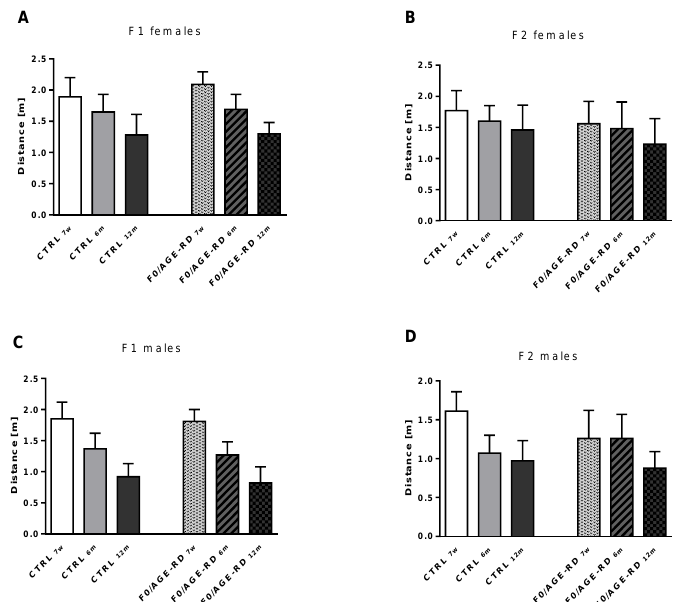
Figure 2. Distance travelled in open field test by o ff spring. F1 females ( A ), F2 females ( B ), F1 males ( C ), F2 males ( D ). Females: GLM (3 × 2 × 2 = age, F0 diet, generation), F (2, 82) = 45.1, p < 0.001; p age and diet , NS; p : age, diet and generation interaction, NS. Males: GLM, F (2, 85) = 103.5, p < 0.001; p age and diet , NS; p : age, diet and generation interaction, 0.018. F2 generation males: GLM, F (2, 47) = 26.4, p = 0.003; puberty, CTRL vs. AGE-RD, p = 0.015; CTRL, shorter distance ran in adulthood and at old age vs. puberty ( p < 0.01), AGE-RD, shorter distance only in old age ( p = 0.018), values are presented as mean + standard deviation (CTRL = groups fed with control chow, F0 / AGE-RD group = F1 and F2 o ff spring of F0 dams fed with AGE-rich diet, 7w = 7 weeks of age, 6m = 6 months of age, 12m = 12 months of age). Anxiety-like behavior: By ageing, o ff spring spent longer time in the central zone of the open field test (F: F (2, 90) = 9.4, p < 0.001; M: F (1, 63) = 5.2, p = 0.017). However, F0 diet showed no significant e ff ect (age and F0 diet interaction: F: p = 0.070, M: p = 0.242; age, F0 diet and generation interaction: F: p = 0.185, M: p = 0.565), (Figure 3A–D). With increasing age, both female (F (2, 85) = 19.6, p < 0.001) and male (F (2, 85) = 20.4, p < 0.001) o ff spring spent longer time in illuminated part of light-dark box. However, GLM did not indicate a significant e ff ect of age and F0 diet (F: p = 0.092; M: p = 0.459) or age, F0 diet and generation interactions (F: p = 0.159; M: p = 0.486), (Supplementary Table S3). Light-to-dark transitions frequency increased with ageing, both in females (F (2, 85) = 13.1, p < 0.001) and in males (F (2, 76) = 21.0, p < 0.001), Table 4. Age and F0 diet ( p = 0.219) and age, F0 diet and generation ( p = 0.882) interactions were insignificant in females, while a significant interaction between age, F0 diet and generation ( p = 0.042) was observed in males. Further analysis revealed that transition frequency was significantly lower in F2 AGE-RD o ff spring compared with their CTRL counterparts ( p < 0.05). Table 4. Light dark box test: Number of light-to-dark transitions.